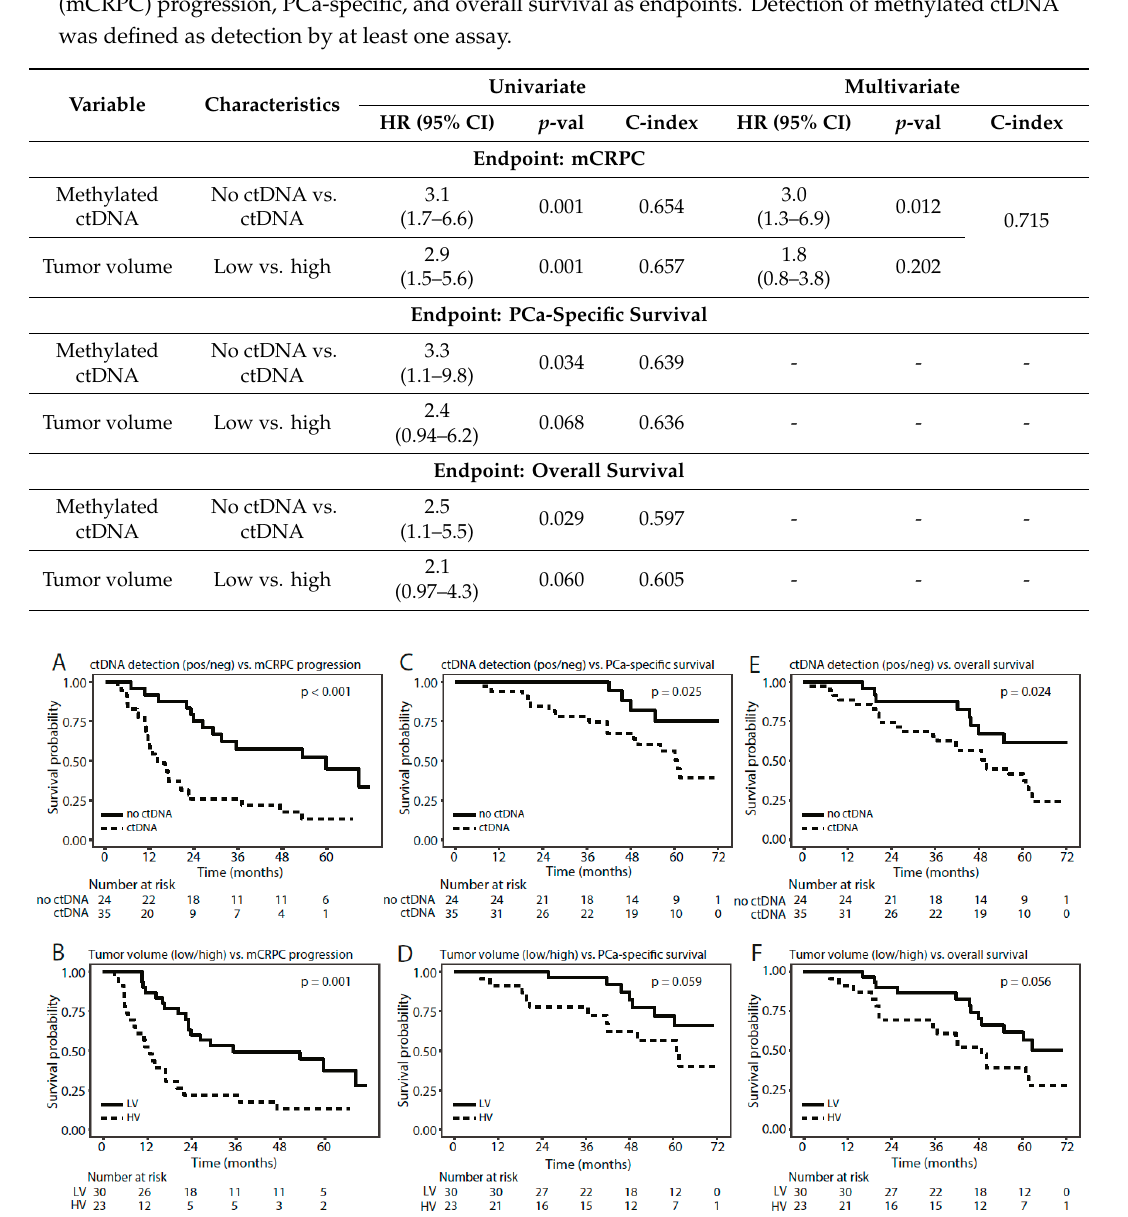
Figure 6. Kaplan–Meier survival analyses for de novo mPCa patients, stratified by ( A , C , E ) detection of methylated ctDNA (any assay) or by ( B , D , F ) tumor volume using ( A , B ) mCRPC progression, ( C , D ) PCa-specific survival, and ( E , F ) overall survival as endpoints. p -values were calculated using log-rank tests.